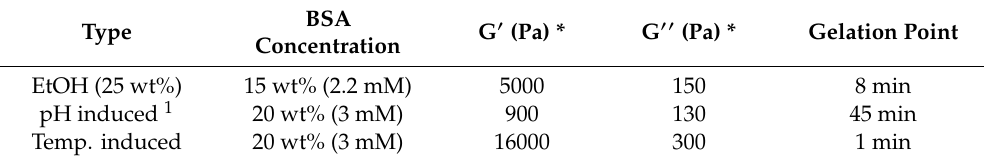
Table 1. The di ff erence in mechanical properties and gelation rate at 37 ◦ C between pH-induced and EtOH-mediated